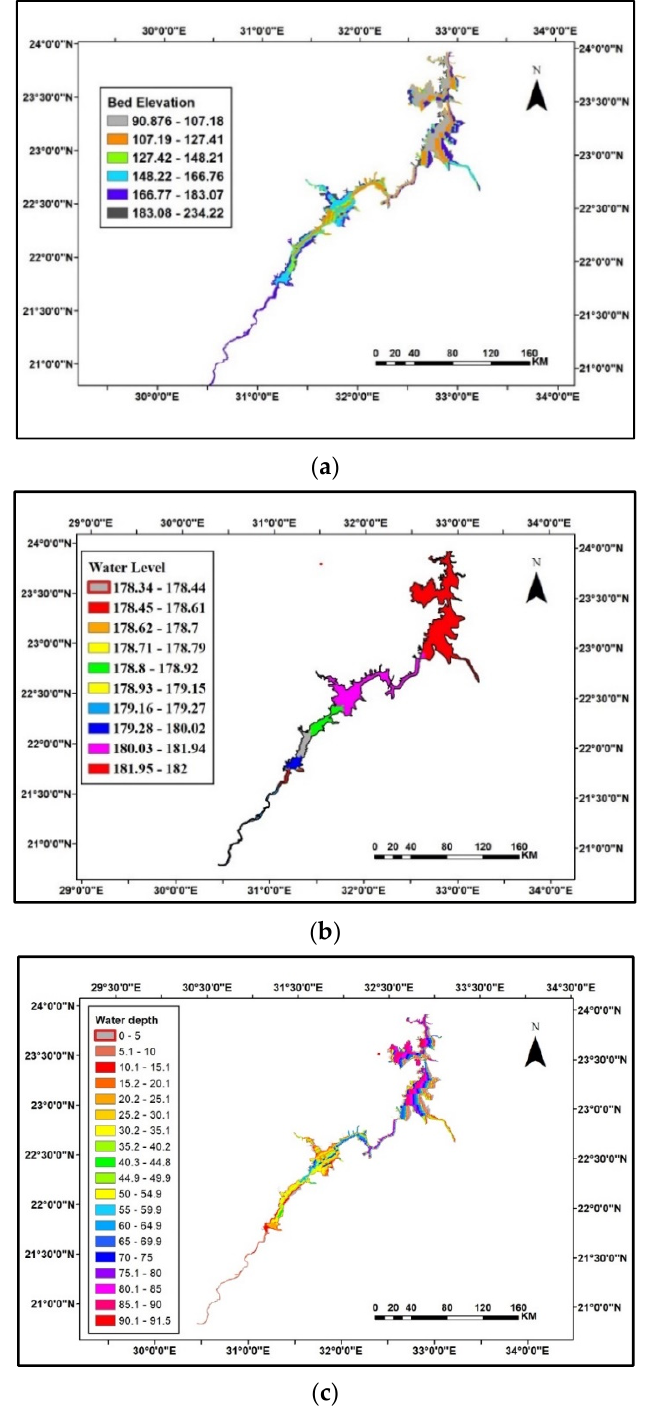
Figure 5. Bed level and water level and depth in Lake Nasser (2020): ( a ) bed level, ( b ) water level, ( c ) water depth.